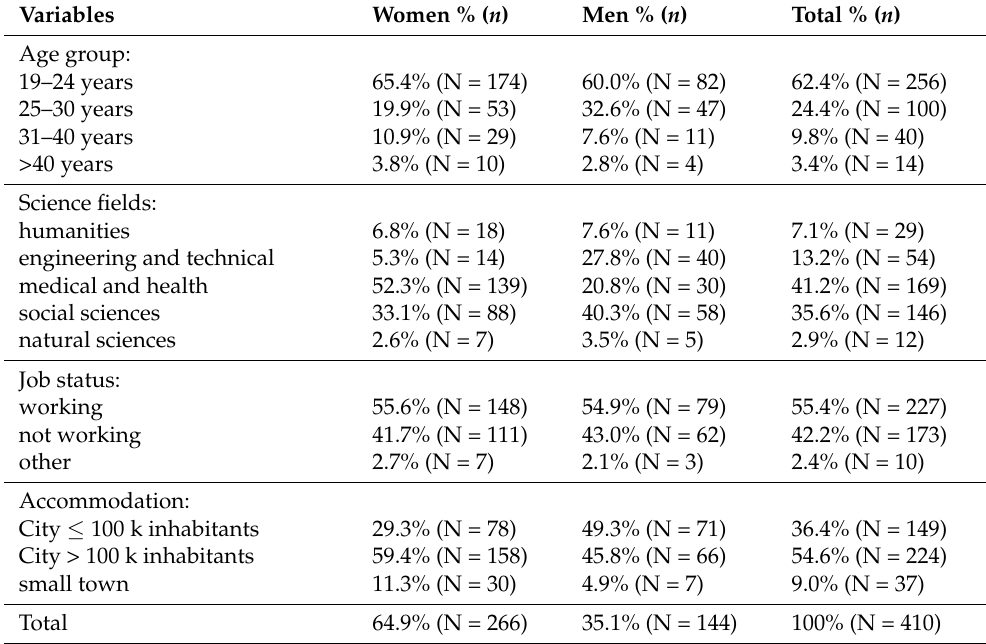
Table 1. Characteristics of the study